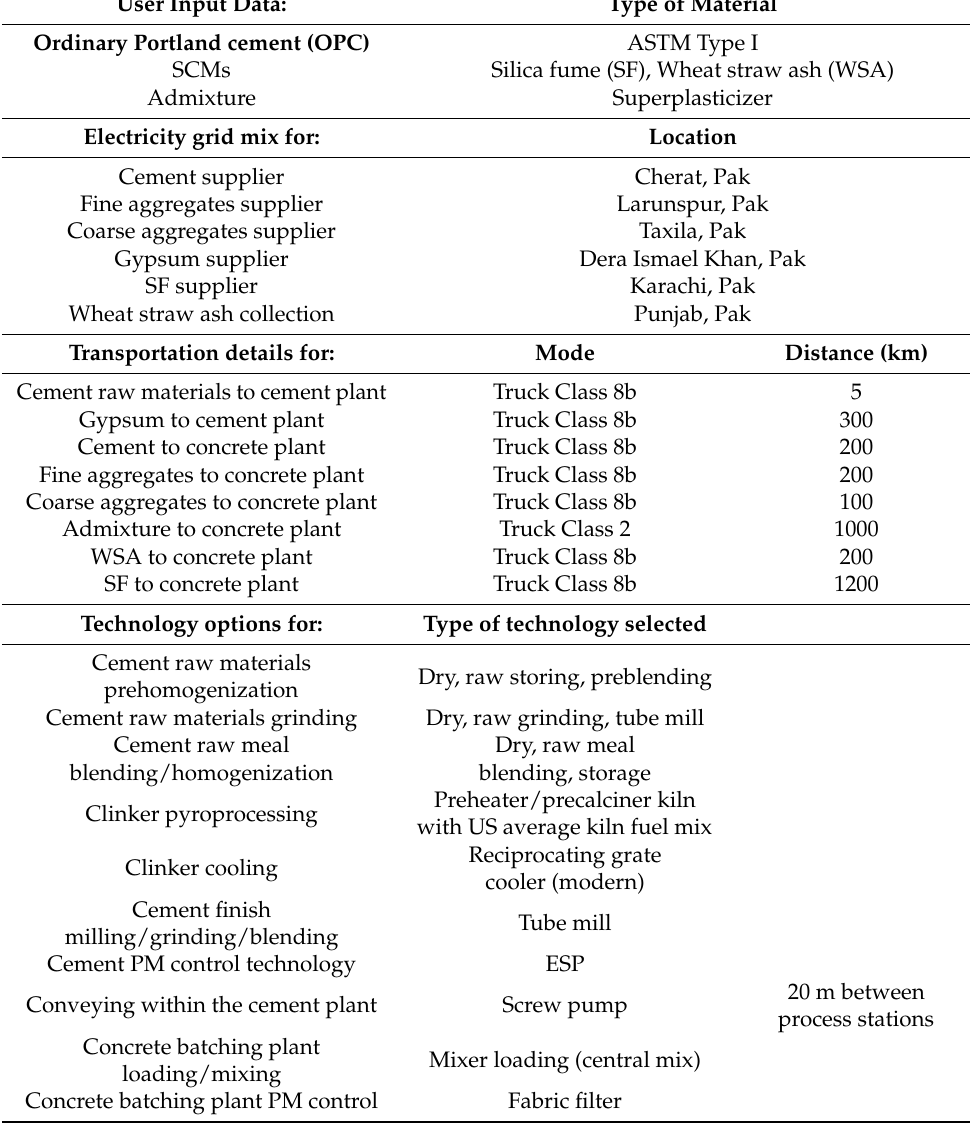
Table 4. Assumptions used in LCA calculations.